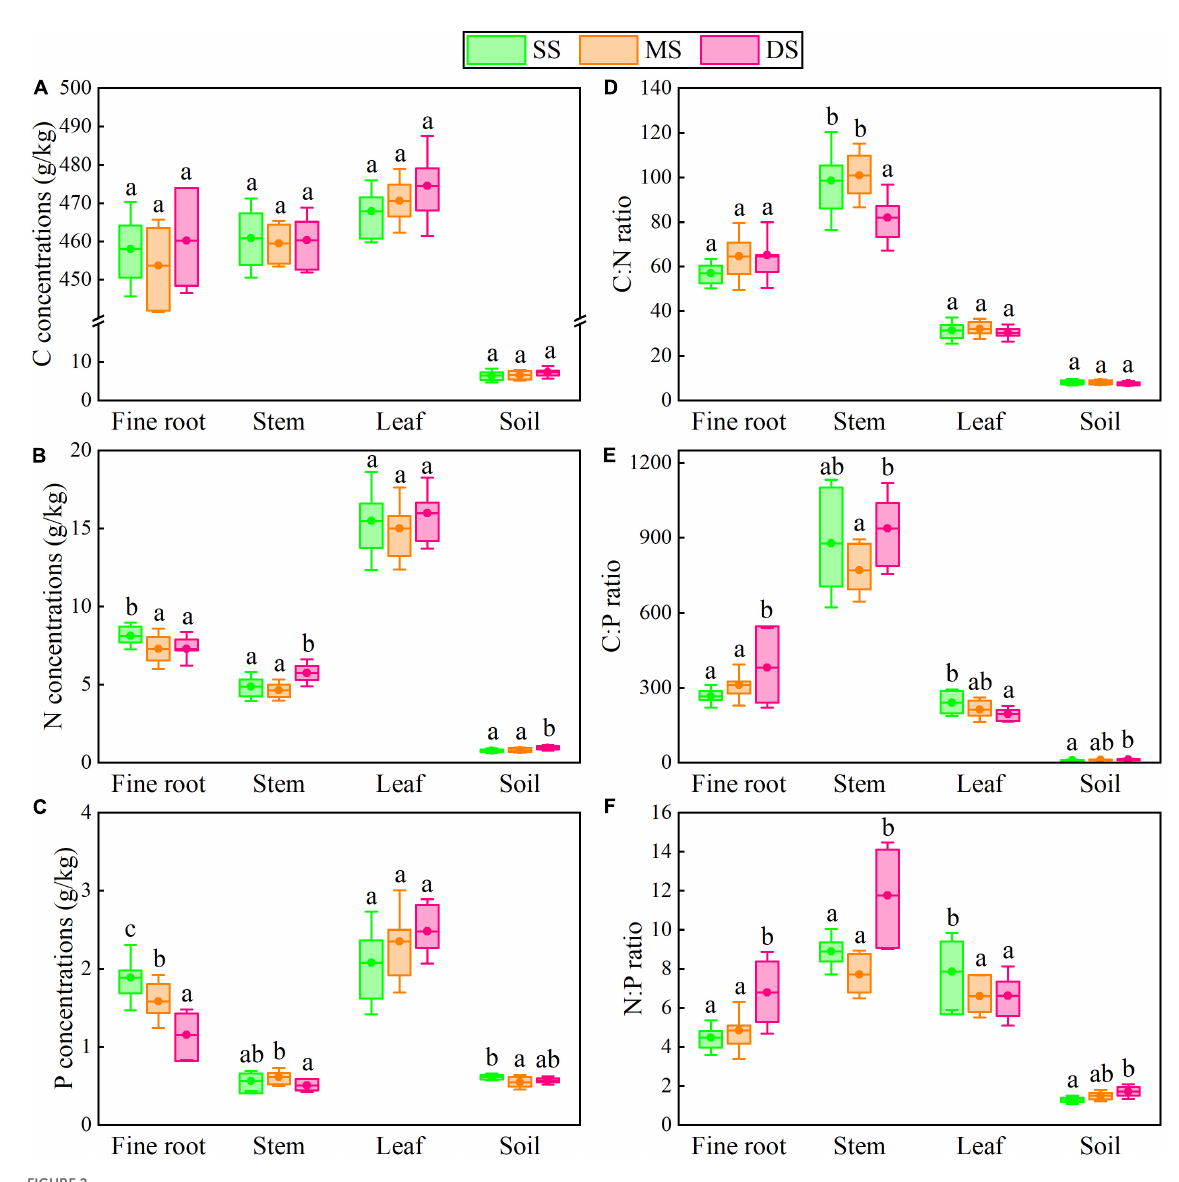
FIGURE2 The C, N, and P concentrations (A–C) and stoichiometry (D–F) in fine roots, stems, leaves, and soils of T. ascendens under different submergence treatments. Data shows a significant difference with different lowercase letters ( p < 0.05) in different submergence treatments (mean with standard error). The boxes give the 25 and 75%